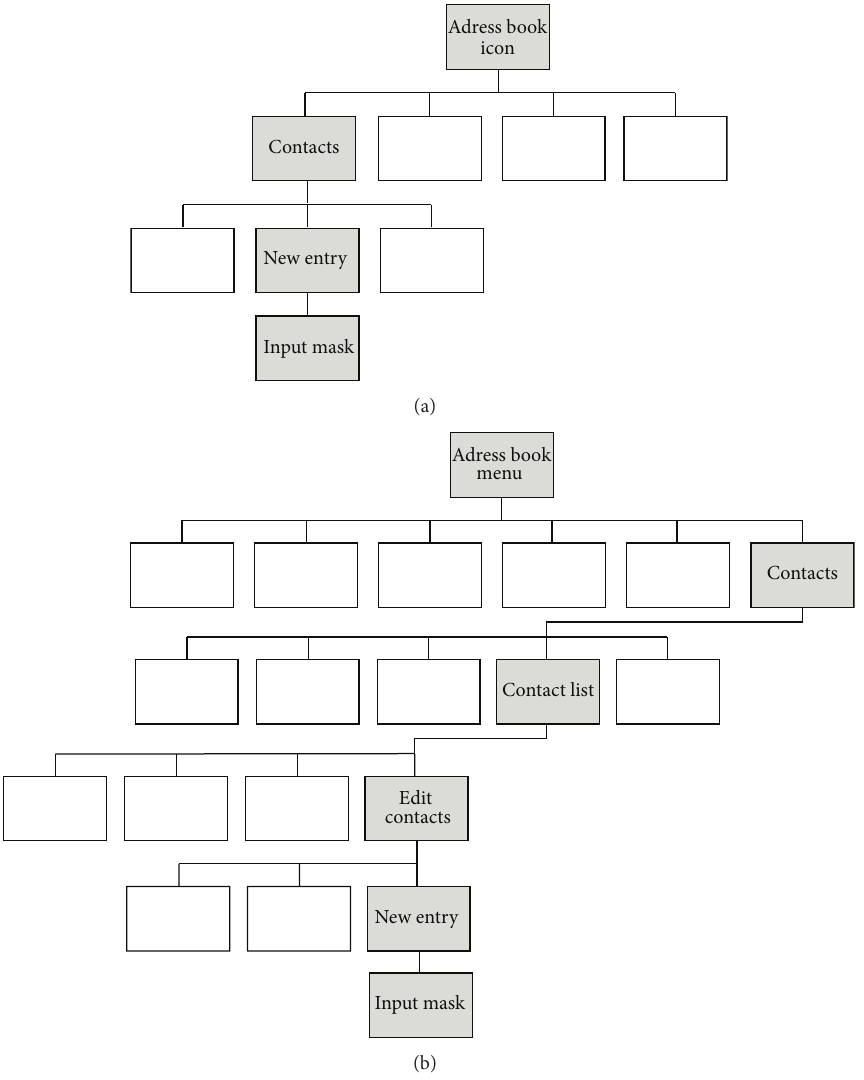
Figure 4: Menu trees of the high usable (a) and the low usable prototype (b); for example: enter a new contact into the address book.